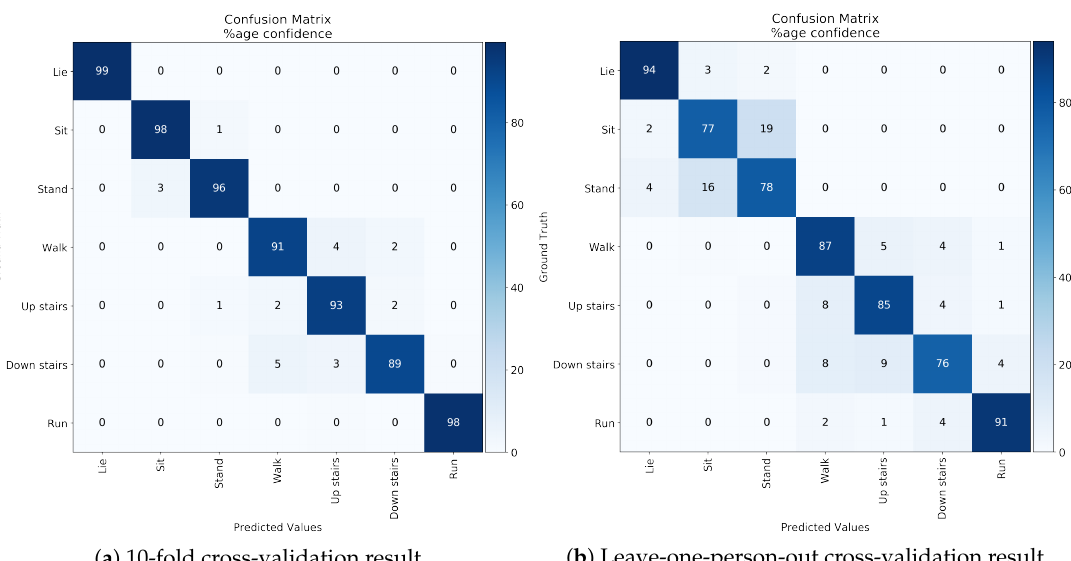
Figure 12. Result of cross-validation for basic activity